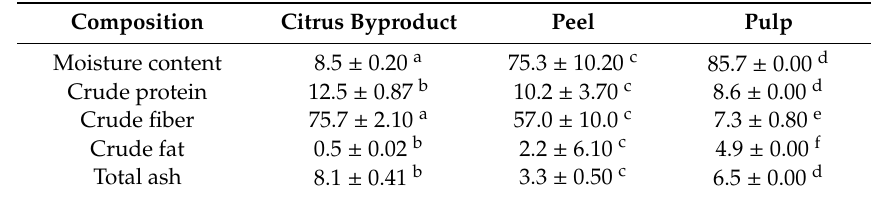
Table 1. The composition of citrus wastes acquired from juice-producing industries; Units are expressed in (g / 100 g).